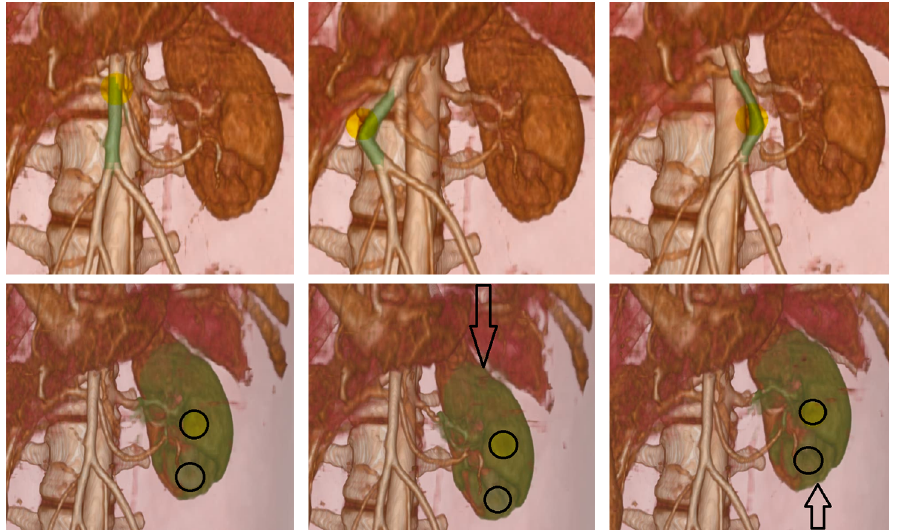
Figure 7. Real-time screen captures of natural hands-on deformation of volumetric anatomy. Top row : in-plane translation of a vein using only one finger. Bottom row : in-plane translation of the selected kidney using two fingers. The arrows show the direction of